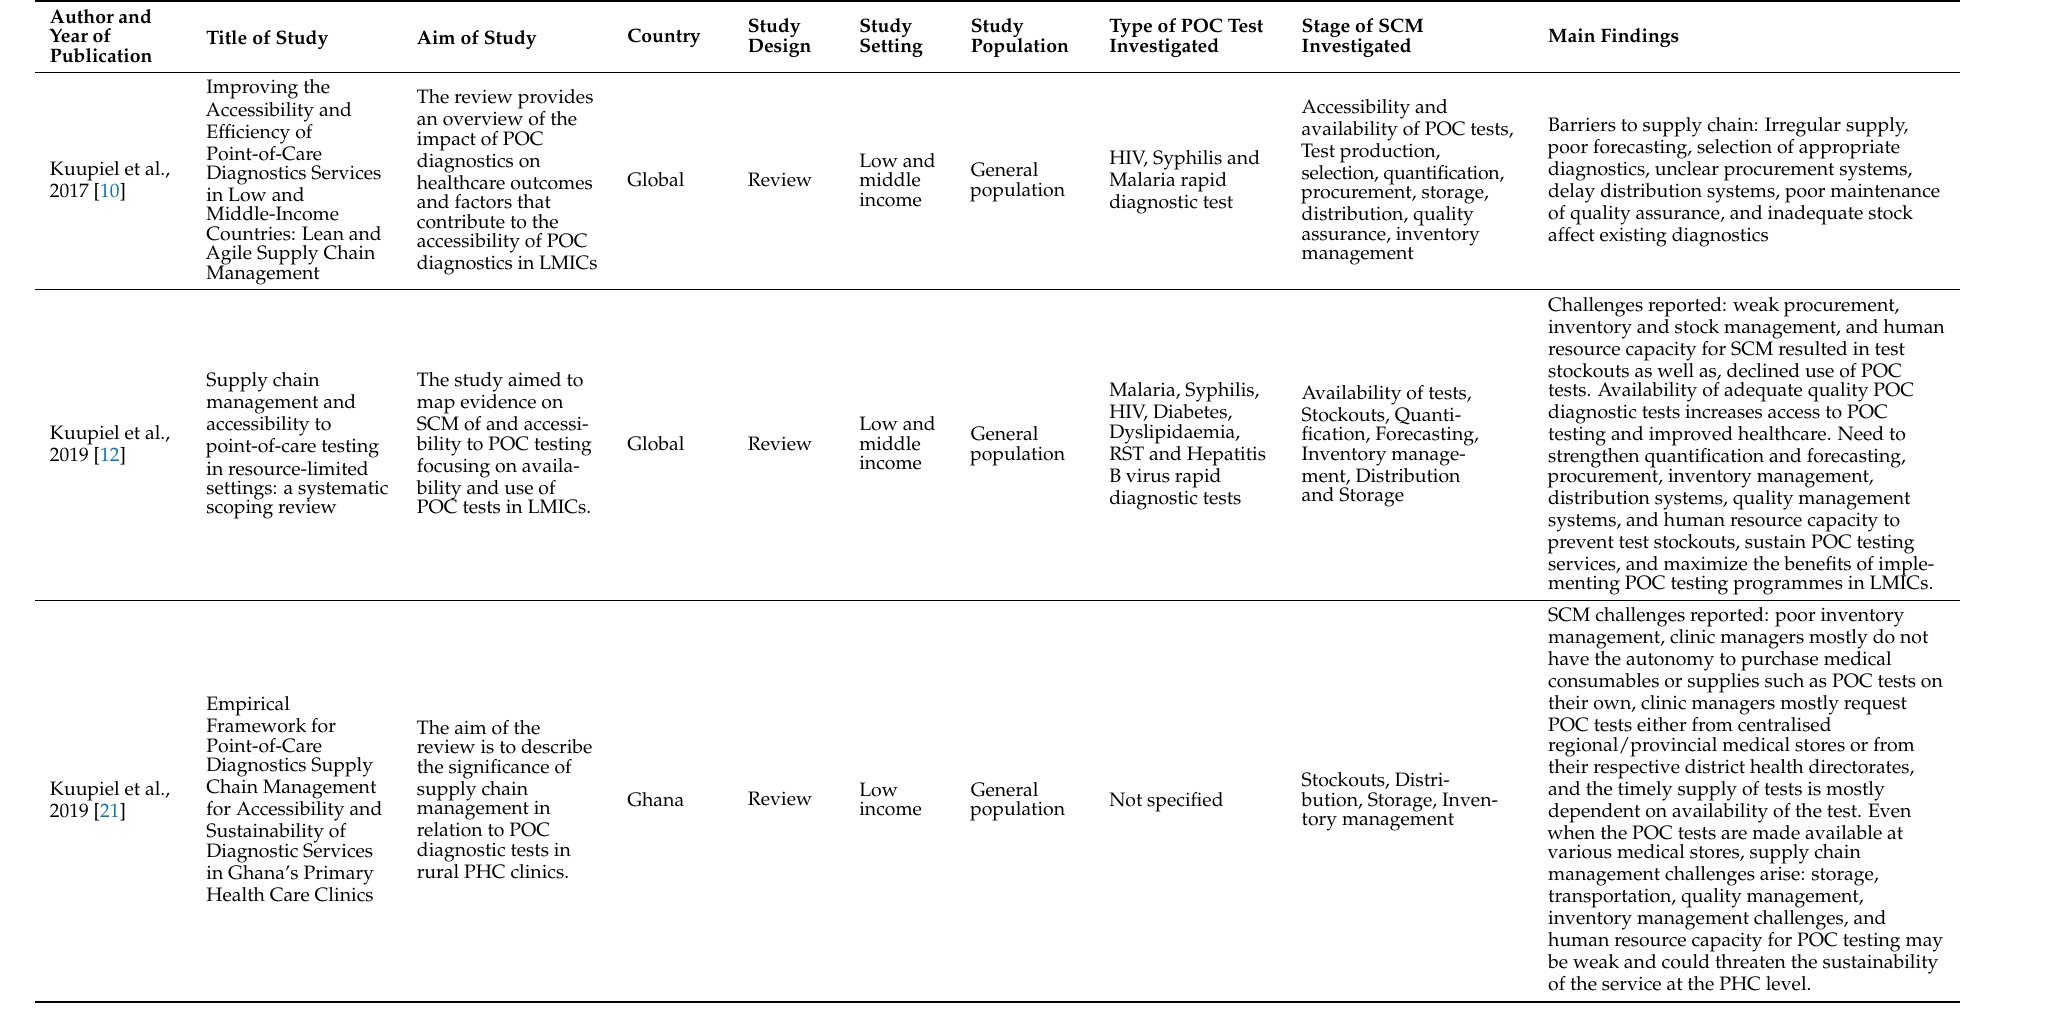
Table 2. Characteristics and findings of the studies included in the scoping